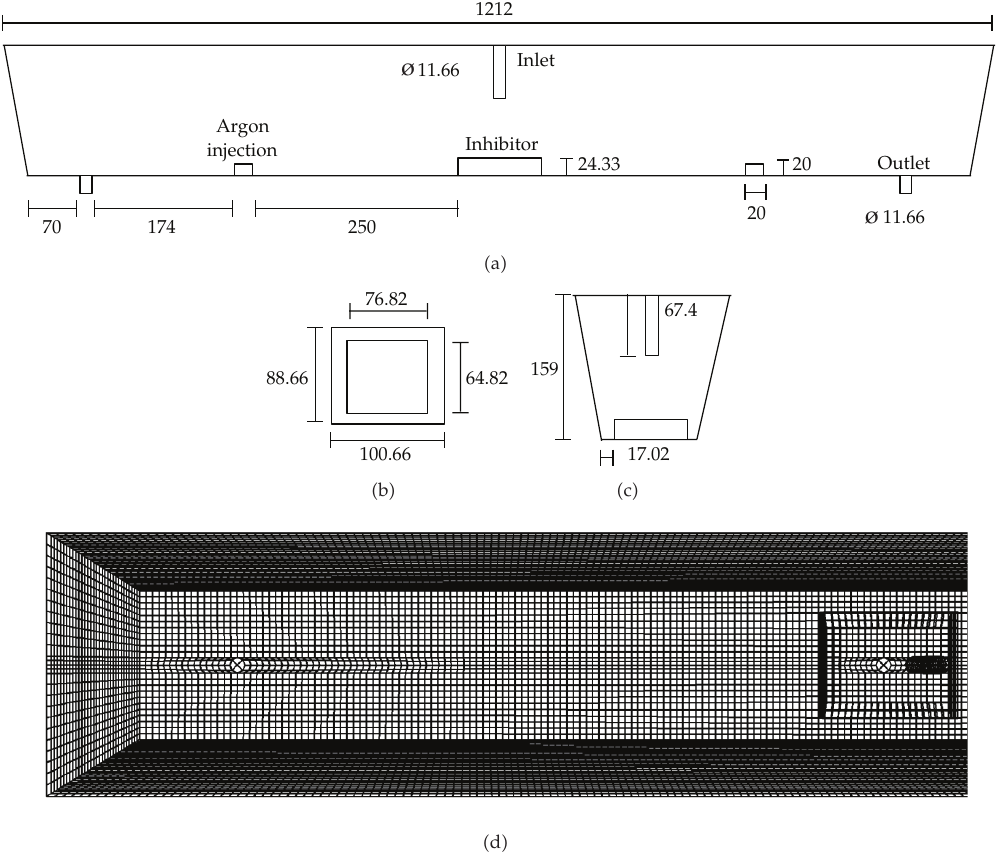
Figure 6: Characteristic dimensions of the continuous casting tundish (cid:4) a (cid:5) Frontal view, (cid:4) b (cid:5) Turbulence Inhibitor (cid:4) TI (cid:5) upper view, (cid:4) c (cid:5) Lateral view, and (cid:4) d (cid:5) Computational